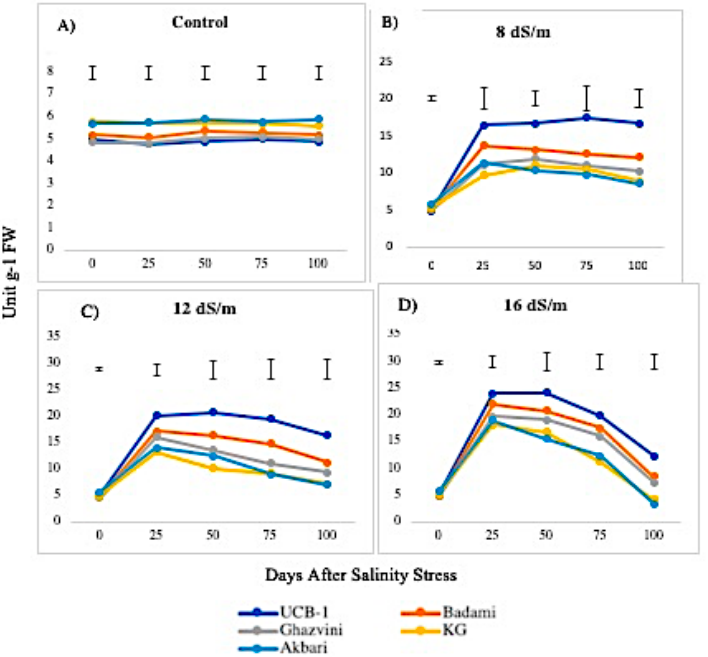
Figure 5. Effect of NaCl-mediated stress on CAT activity in leaves of pistachio.